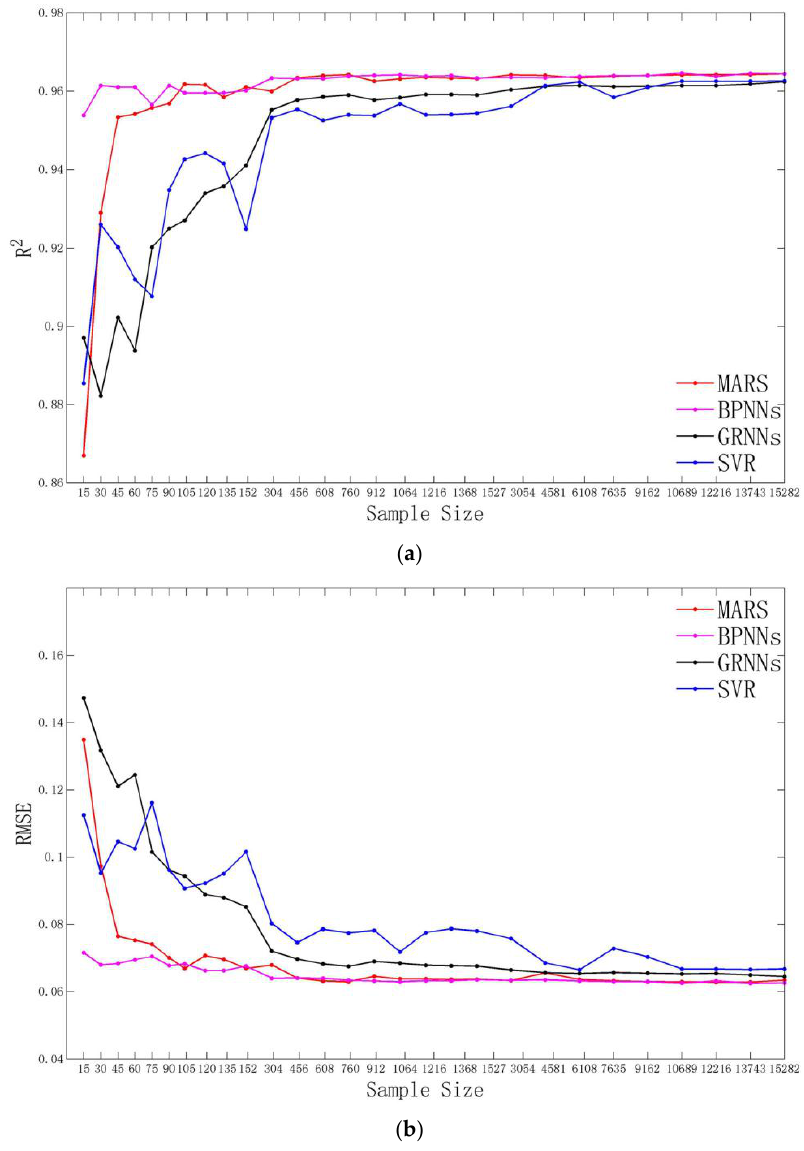
Figure 2. Performance of the four methods with different training sample size. ( a ) Coefficient of determination (R 2 ); ( b ) Root mean squared error ( RMSE).